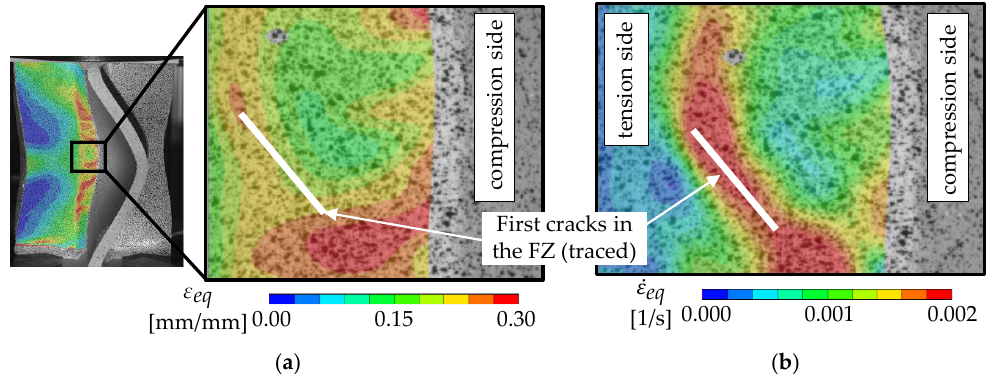
Figure 20. ( a ) Equivalent strain and ( b ) strain rate in the fusion zone of a 12-mm-plate-thickness specimen immediately before crack initiation calculated by DIC.